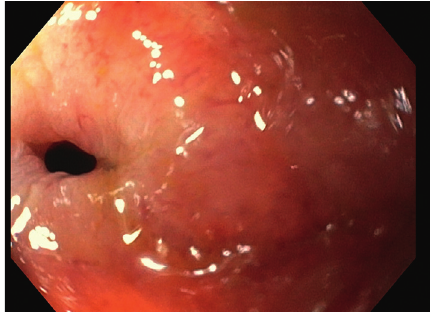
Figure 2: Flexible sigmoidoscopy 20cm from the anal verge demonstrating a 10mm-long anastomotic stricture with a luminal diameter of 8mm.